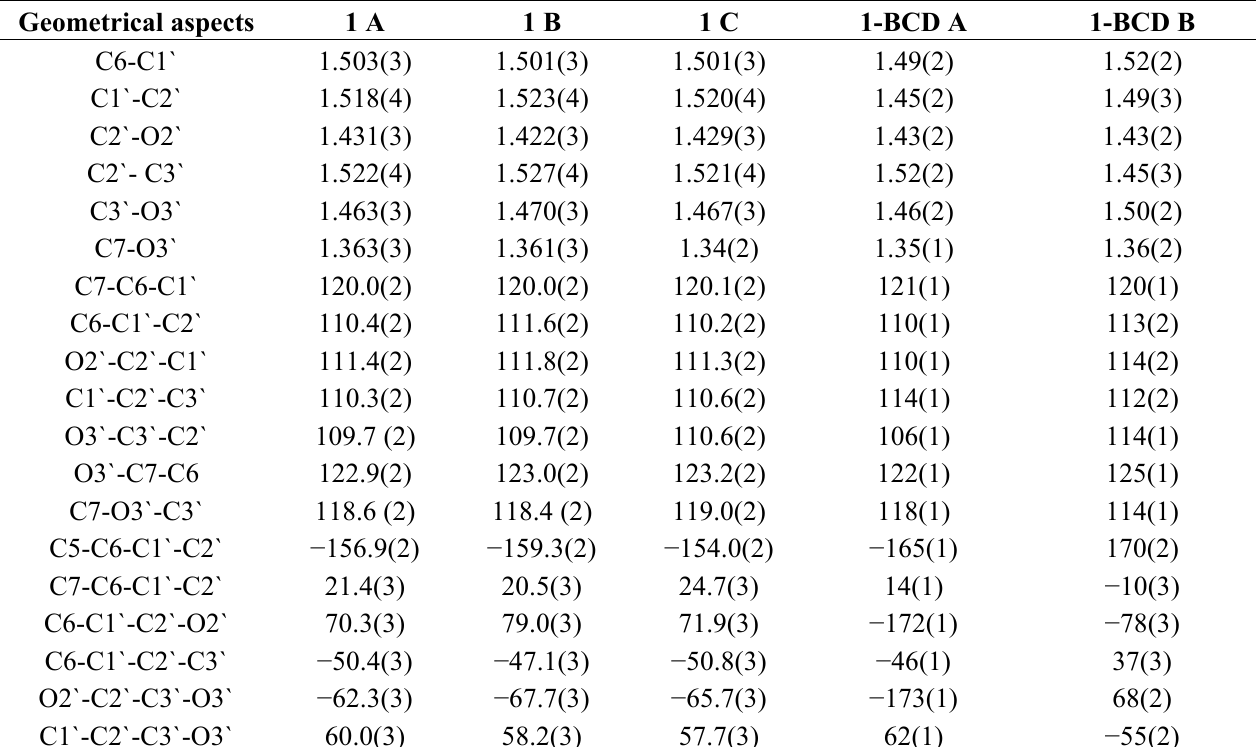
Table 2. Selected structural features (bond lengths (Å), valence and torsion angles (°)) of the crystal structures of aegelinol ( 1 , three molecules in asymmetric unit (A, B, C) ) and its inclusion complex in β -cyclodextrin ( 1-BCD two molecules in asymmetric unit (A, B)